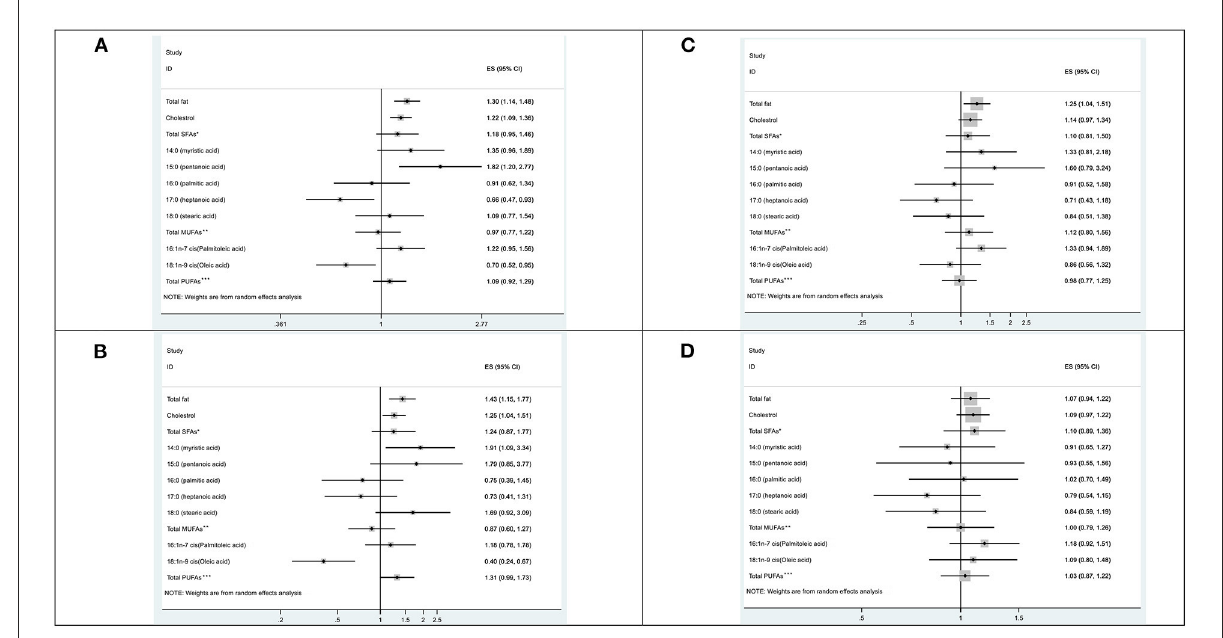
FIGURE2 Forst plots according to the odds ratios, and 95% confidence intervals for colorectal cancer risk associated with different fat intake, by anatomical sub-site; (A) Colon cancer, (B) Proximal colon cancer, (C) Distal colon cancer, (D) Rectum cancer. *Saturated fatty acids; **Monounsaturated fatty acids; ***Polyunsaturated fatty